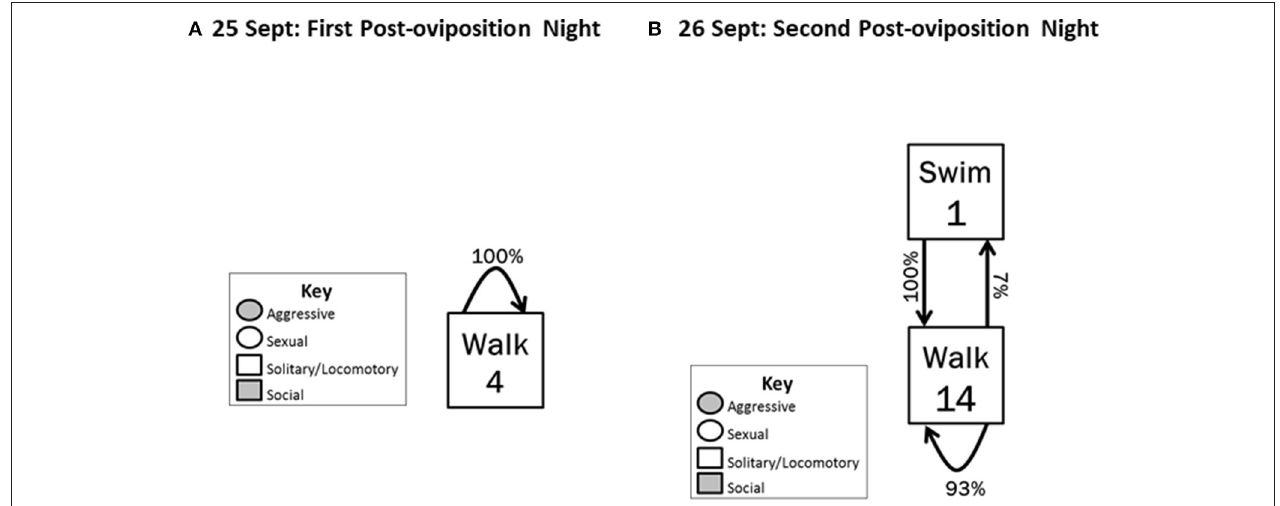
FIGURE 4 | Behavioral transitions during (A) the first night post-oviposition and (B) the second night post-oviposition. Locomotory behaviors were followed (arrows) by only other locomotory behaviors. Frequency of initiating behavioral actions (inside box) and the % time the initiated action was followed (arrow) by another action are indicated.